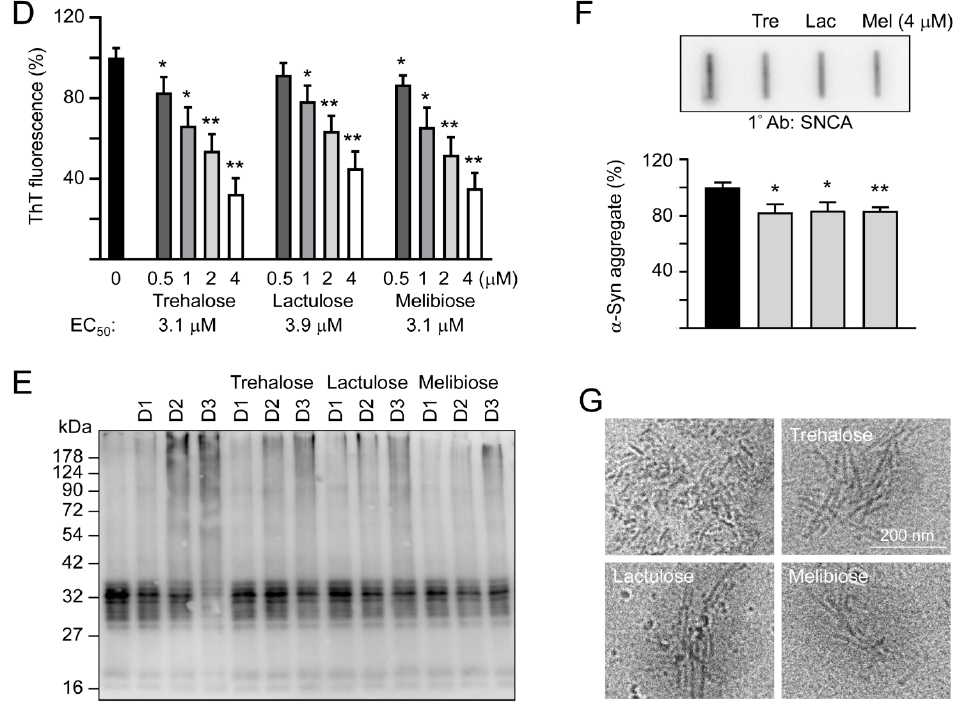
Figure 2. SNCA-His protein and α -synuclein aggregation examined by thioflavin T fluorescence, SDS-PAGE / immunoblot, filter trap assay, and cryo-TEM. ( A ) SNCA-His protein and IPTG-induced expression in E. coli BL21(DE3). α -Synuclein (140 amino acids, marked in black) was fused in-frame to a 6-amino acid His tag (marked in red) via a 2 amino-acid linker (marked in blue). Bacterial cell lysates added with or without IPTG and affinity resins-purified protein were examined by Coomassie blue staining of a 10% SDS-PAGE gel. ( B ) α -Synuclein fibril formation. SNCA-His (1 µ g / µ L) was incubated at 37 ◦ C for 1–3 days and fibril formation was determined by a thioflavin T fluorescence assay ( n = 3) and ( C ) examined under a cryo-TEM. ( D ) Thioflavin T binding assay of trehalose and analogs. SNCA-His was incubated with or without trehalose and analogs (0.5–4 µ M) at 37 ◦ C for three days and fluorescence levels were measured after added with thioflavin T ( n = 3). For normalization, the relative fluorescence level of SNCA-His alone was set as 100%. The half maximal e ff ective concentration (EC 50 ) of each disaccharide to reduce aggregation is shown below the columns. ( E ) Time-resolved electrophoretic analysis of α -synuclein aggregation. SNCA-His was incubated with or without trehalose and analogs (4 µ M) at 37 ◦ C for 1–3 days and α -synuclein aggregation was examined by immunoblot probing with the α -synuclein antibody. ( F ) Filter trap assay ( n = 3) of α -synuclein aggregation with or without trehalose (Tre), lactulose (Lac) or melibiose (Mel) (4 µ M) treatment. After three days, the SDS-insoluble aggregates trapped on the filter were detected with the α -synuclein antibody. To normalize, the relative trapped α -synuclein without disaccharide treatment is set as 100%. ( G ) Cryo-TEM examination of α -synuclein aggregation with or without trehalose (Tre), lactulose (Lac) or melibiose (Mel) (4 µ M) treatment for three days. p values: comparisons between with and without disaccharide treatment (*: p < 0.05, **: p < 0.01, ***: p < 0.001; two-tailed Student’s t